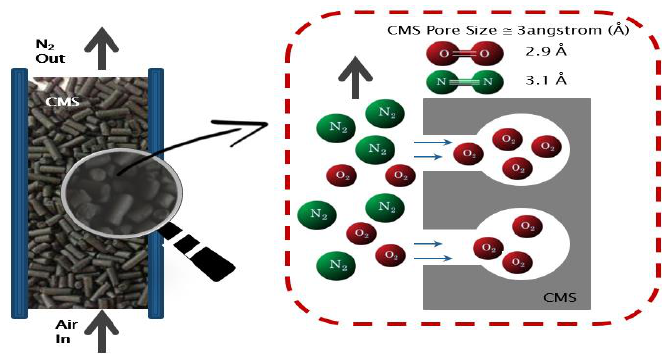
Figure 1. Selective adsorption mechanism of CMS material.